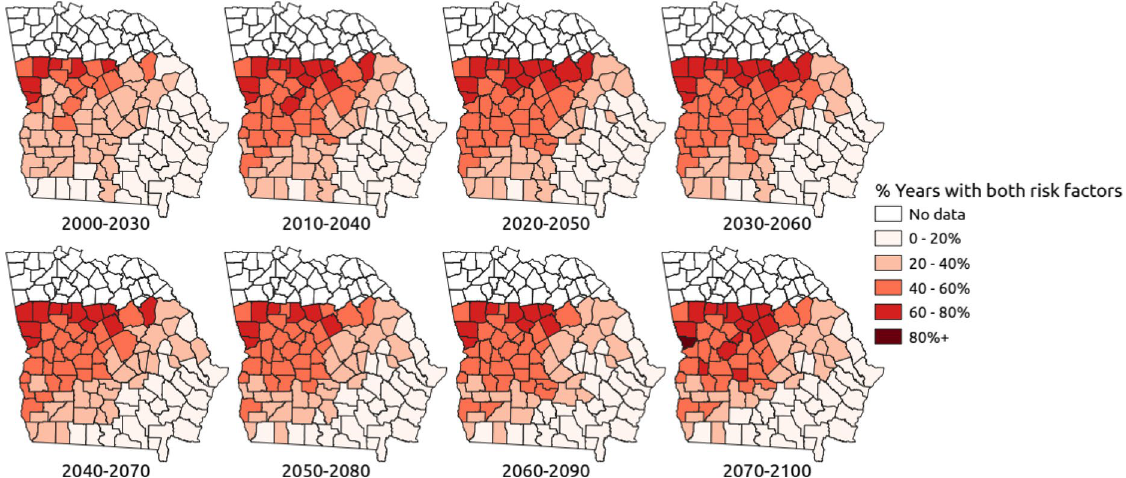
Figure 4. County maps of southern Georgia, USA, with the percentage of years predicted to exceed 2 weather risk factor thresholds assuming the RCP 4.5 scenario.